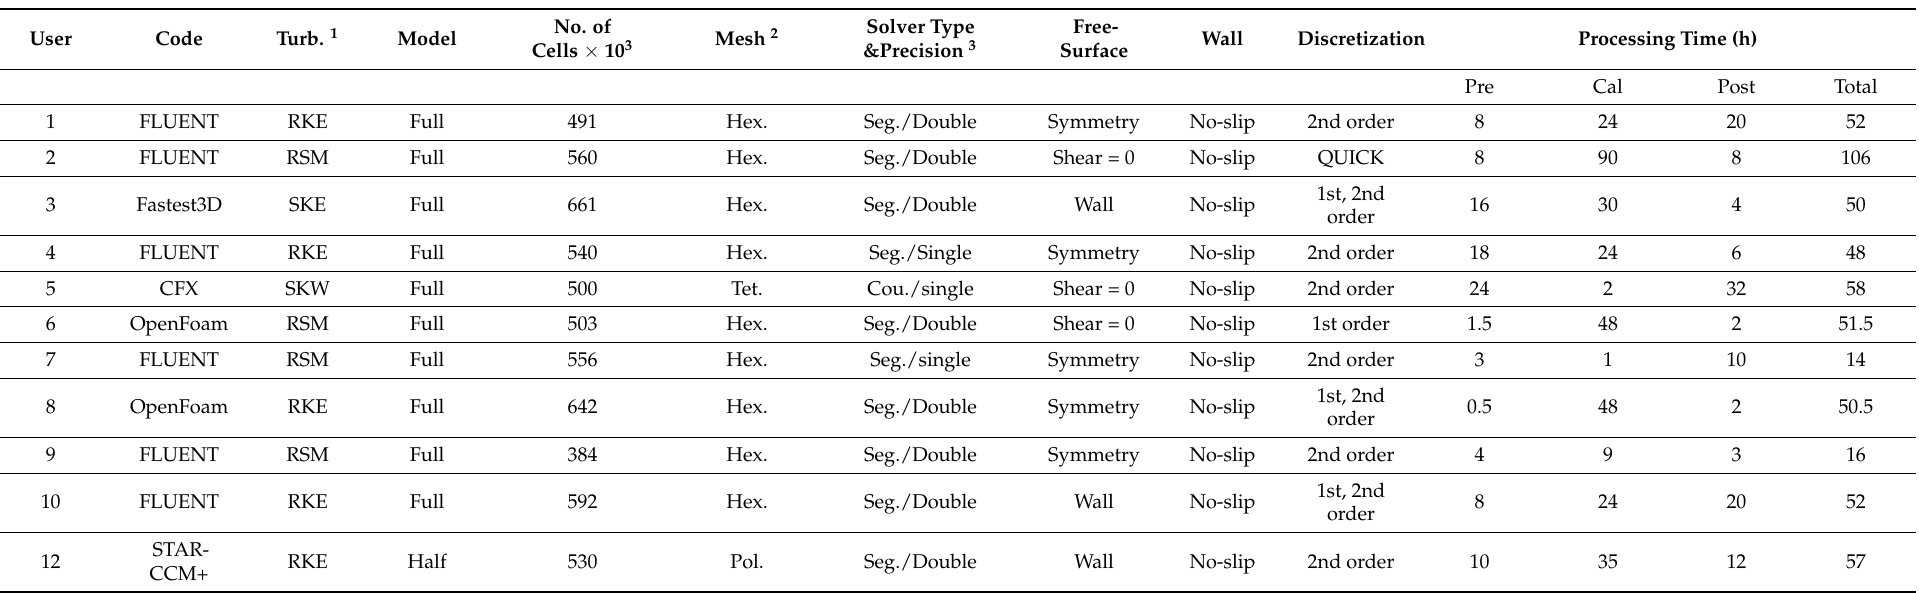
Table 3. Summary of user